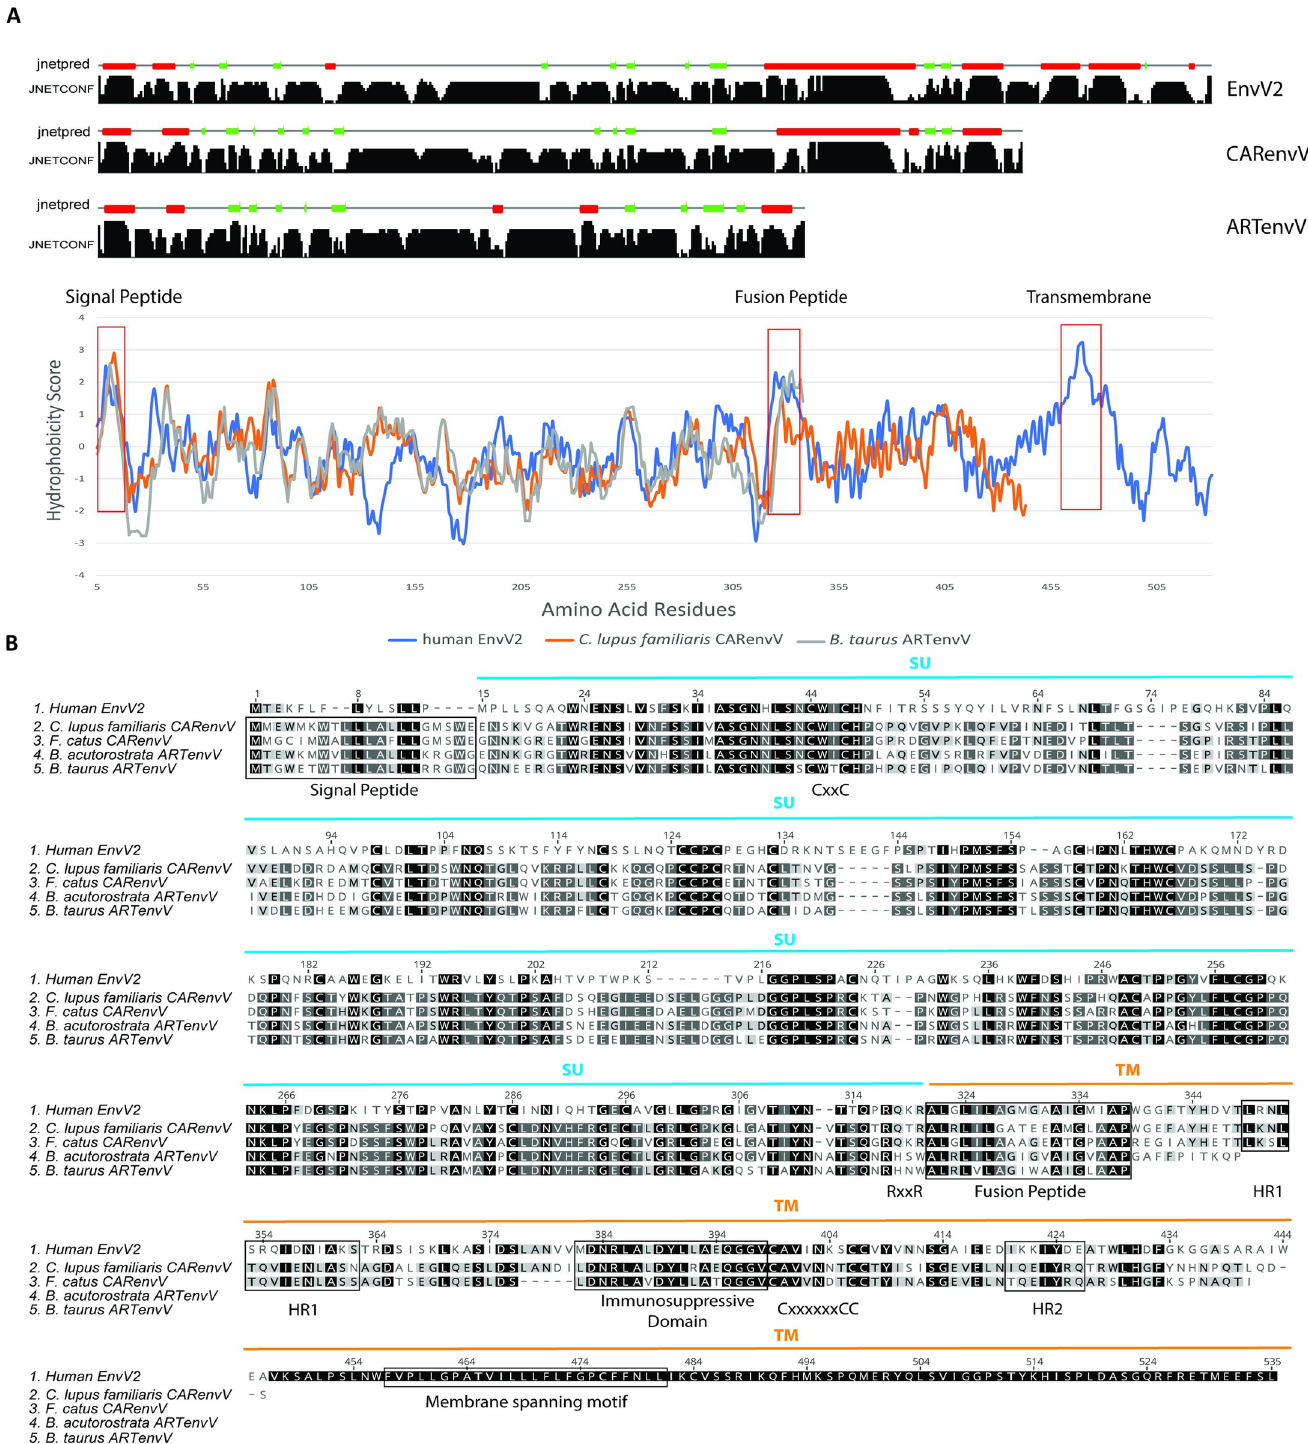
Fig 6. Structural features of CARenvV and ARTenvV. A. Secondary structure predictions (top panels) and hydrophobicity profiles (lower graph) are shown for human EnvV2 (blue), C . lupus familiaris CARenvV (orange) and B . taurus ARTenvV (gray). Jnetconf shows the confidence levels for the secondary structure prediction while Jnetpred shows the consensus prediction. Red boxes indicate alpha helices and green boxes indicate beta sheets in the secondary structure prediction. The predicted locations of key structural features are indicated on the hydrophobicity profile graph. B. Amino acid alignment of human EnvV2, C . lupus familiaris , and F . catus CARenvV, and B . taurus and B . acutorostrata ARTenvV is shown. Predicted locations of the SU (blue) and TM (orange) domains, signal